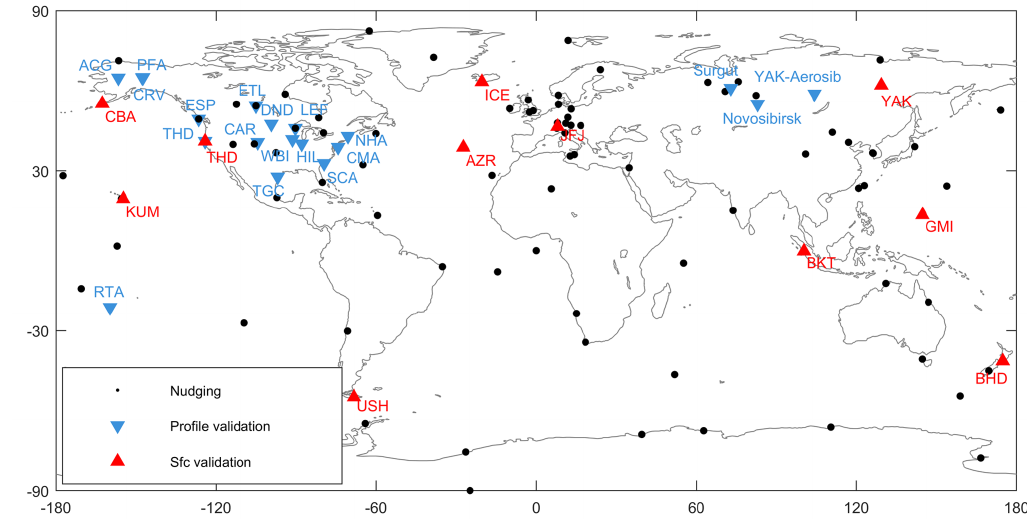
Figure 1. Map of surface and profile locations used for nudging or validation. For profiles that span a larger domain, only the centre location is